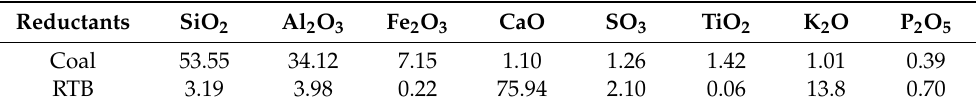
Table 4. Composition of ash in the coal and RTB samples (wt.%).